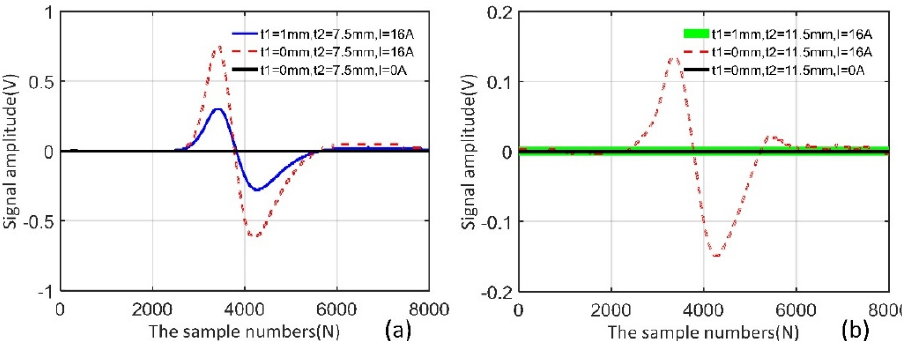
Figure 12. Experimental results. ( a ) far-side surface defect of a 7.5 mm thick specimen, ( b ) far-side surface defect of an 11.5 mm thick specimen.